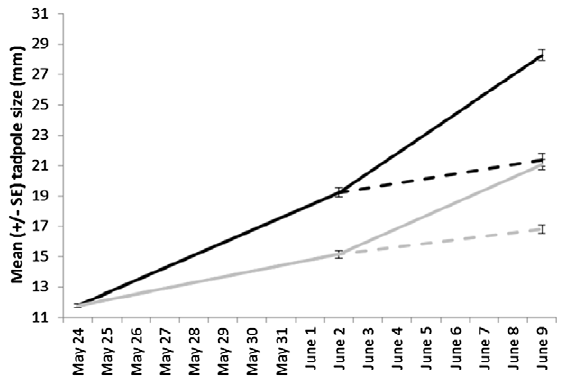
Figure 1. Mean tadpole length measured at the beginning of the experiment (subsample: May 24; N=60), one day post- conditioning (June 2; N=18/treatment), and 8 days post- conditioning (June 9; N= 30–36/treatment). Tadpoles were initially maintained under warm (black) or cold (grey) conditions to obtain two distinct size classes. After conditioning tadpoles were maintained under warm temperatures to promote fast growth rate (solid lines) or cold temperatures to promote a slow growth rate (dashed lines).